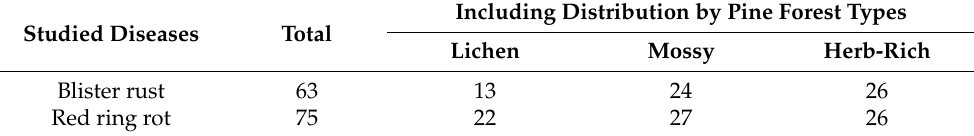
Table 1. The number of plots (75 in total): 63 infected with Scots pine blister rust and 75 affected by red ring